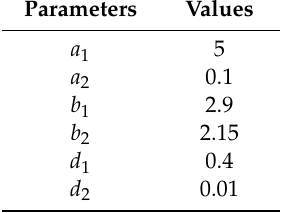
Table 1. The values of the parameters